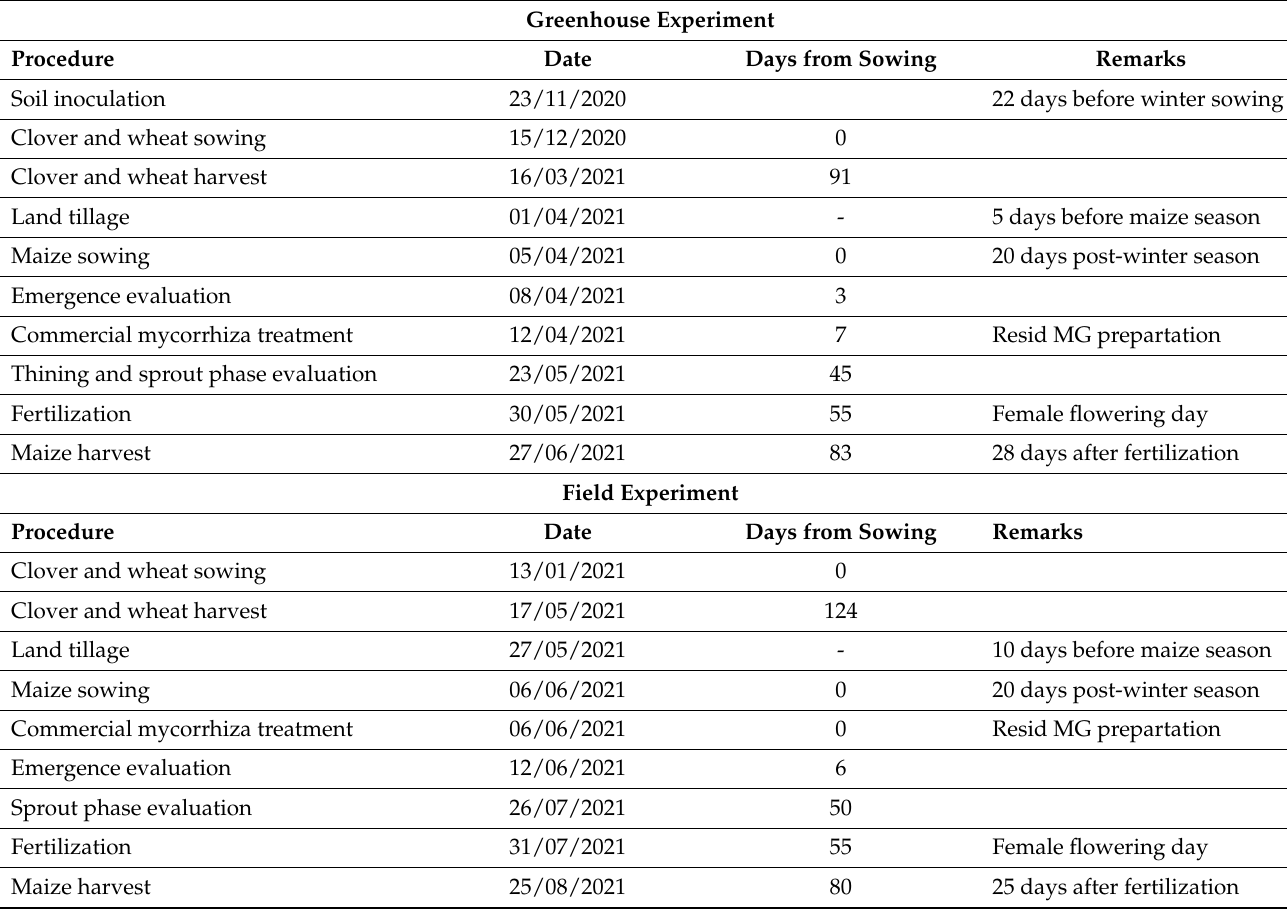
Table 1. Timetable for the greenhouse and field